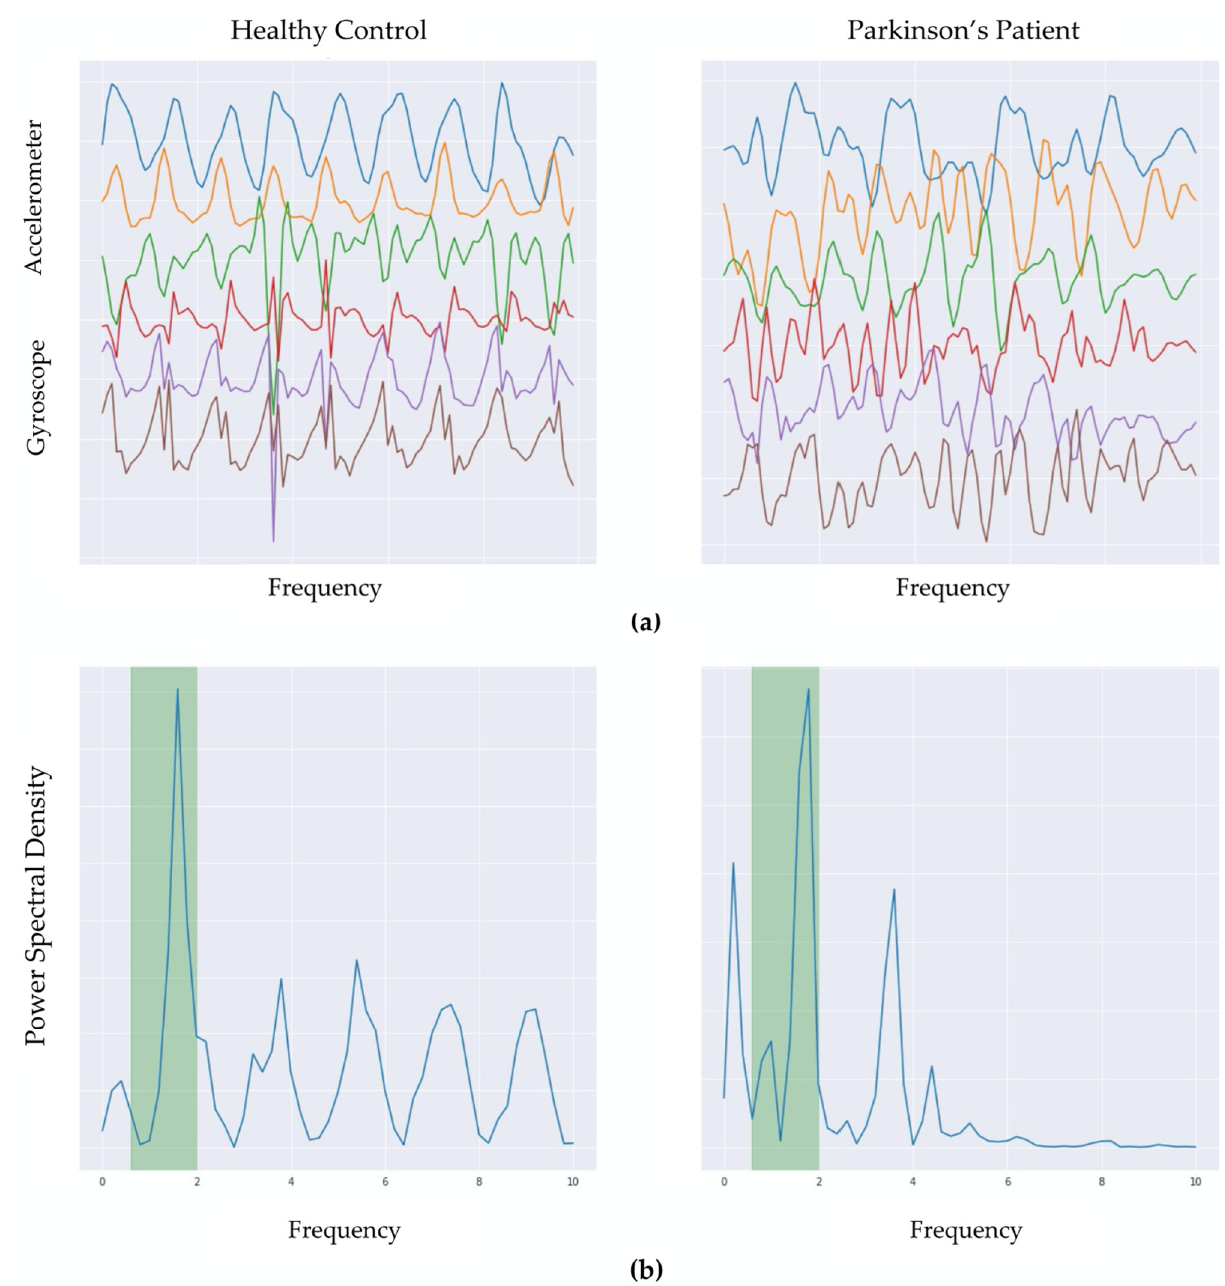
Figure 3. ( a ) Temporal characteristics (in normalized units) of a single 5-s event as measured by the triaxial (x, y, z axis) accelerometer (top 3 traces) and triaxial gyroscope (bottom 3 traces). These examples illustrate an identified walk-like event for HC (left) and PD (right). ( b ) Frequency spectrum power (power spectral density) of these 5-s windows, with the highlighted column illustrating that a sinusoidal frequency within the walking range (0.6–2 Hz) dominates the frequency power.